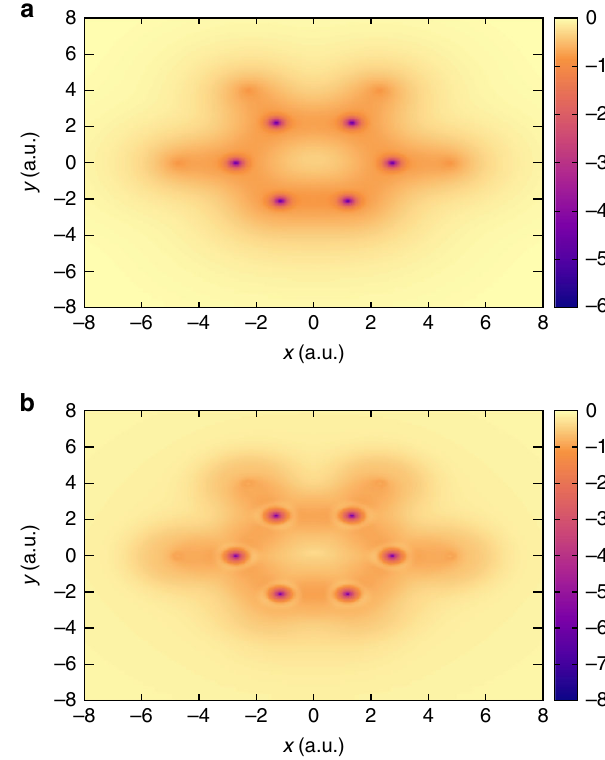
) for C 6 H 4 . Fig. 9 Comparison of exchange-correlation potentials ( v xc a LDA-based exchange-correlation potential. b Exact exchange-correlation potential. In both the cases, the v (in a.u.) is presented on the plane of the xc molecule. Refer to Supplementary Table 3 for the